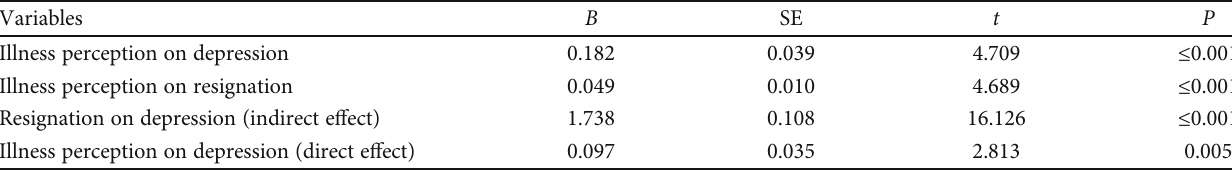
Table 4: Mediation analysis of resignation coping style on the relationship between the illness perception and depressive symptoms.